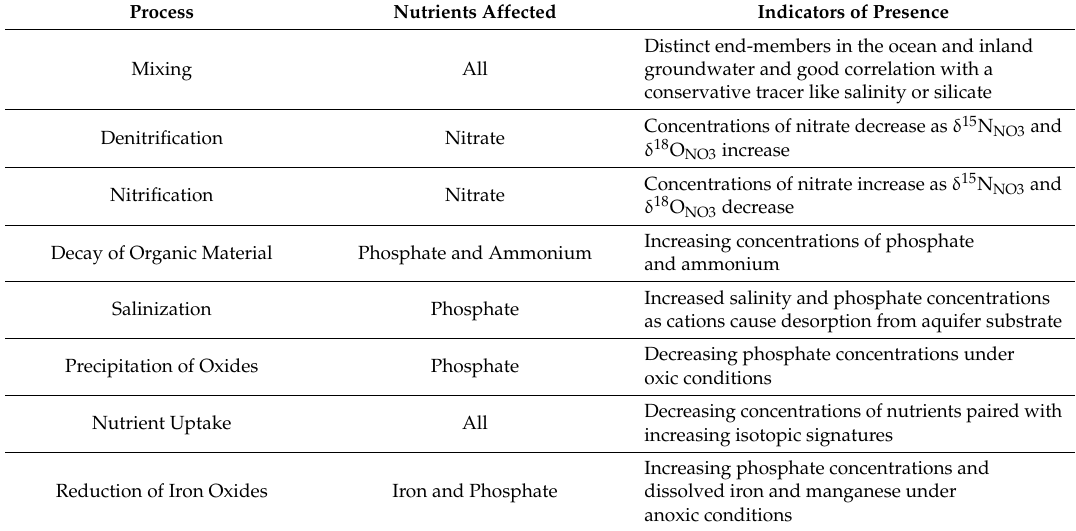
Table 1. Summary of processes that affect nutrient concentrations in coastal